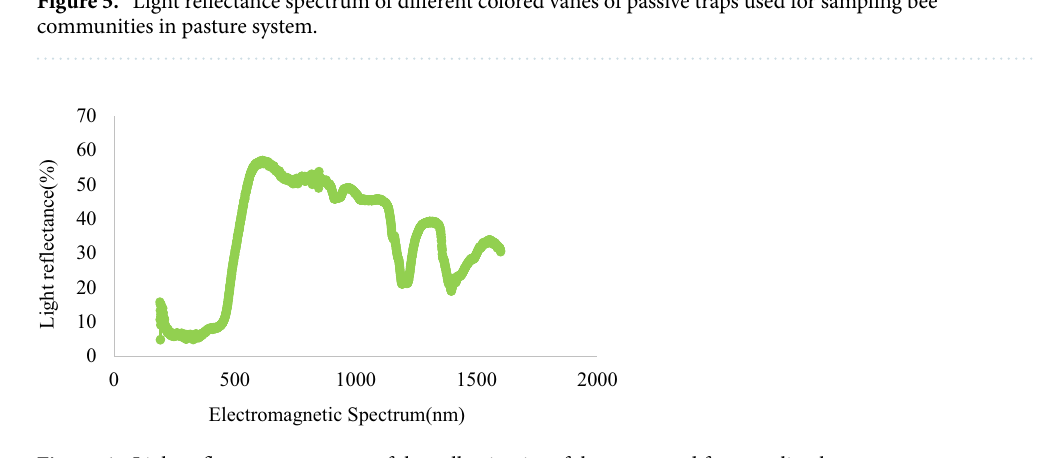
Figure 6. Light reflectance spectrum of the collection jar of the traps used for sampling